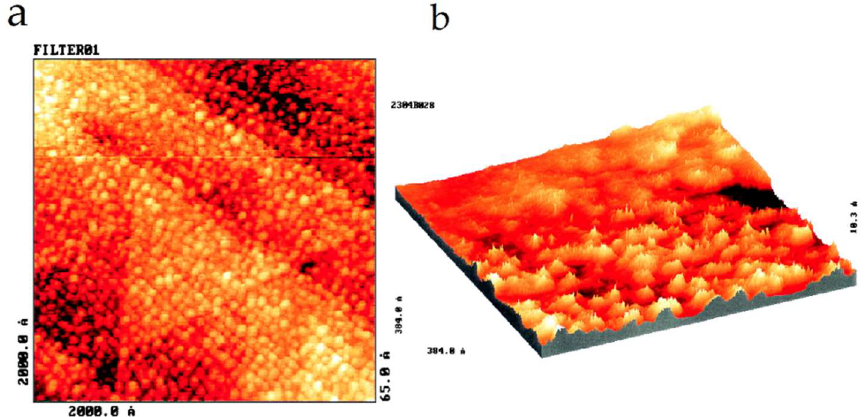
Figure 4. STM images of protein azurin deposited on Au(111). The spots represent individual azurin molecules ( a ). The 3D image shows the proteins exhibited a high central contrast that was interpreted as an area of high tunneling conductivity ( b ). STM analysis was performed in liquid. Reprinted with permission from Ref. [77] . Copyright (1999), National Academy of Sciences.